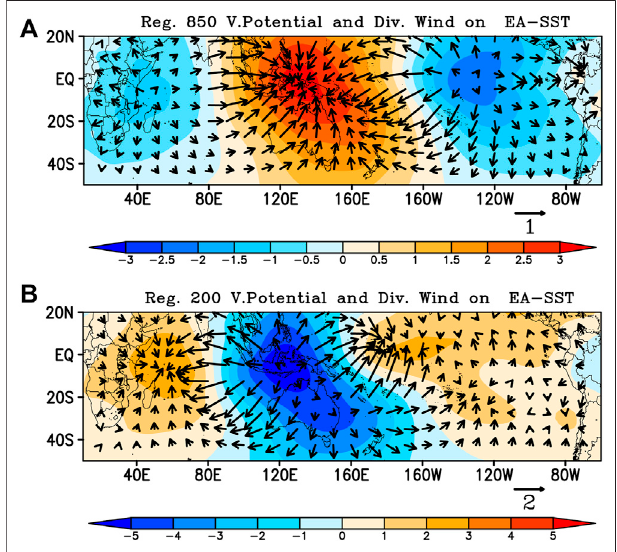
FIGURE 8 | Regressions of (A) 850 hPa velocity potential (shading; 10 6 m 2 s − 1 ) and divergent winds (vectors; m s − 1 ), (B) 200 hPa velocity potential (shading; 10 6 m 2 s − 1 ) and divergent winds (vectors; m s − 1 ), against the EA-SST index during OND season for 1950 –